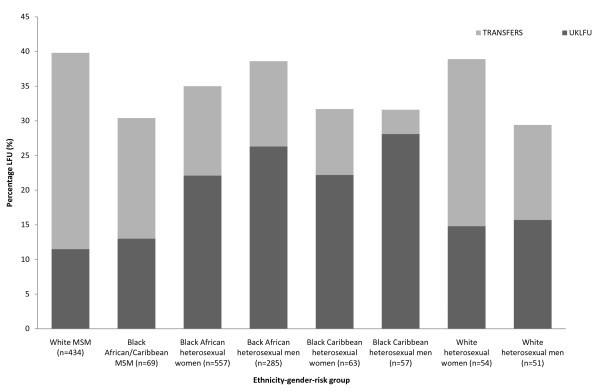
Percentage of Ethnicity-Gender HIV Risk groups LFU